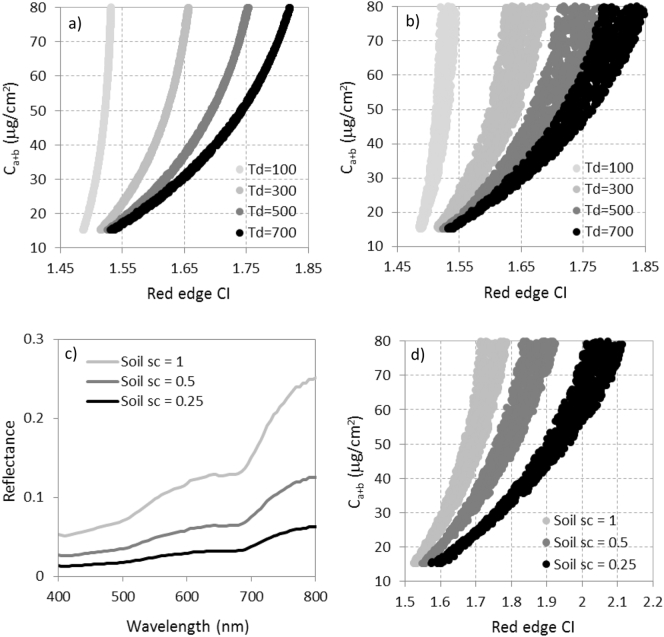
Simulations conducted to display the effects of the tree density (Td) variation for fixed (a) and variable crown diameter (Cd) and tree height (Ch) (b) on the red-edge chlorophyll index (CI) as a function of needle Ca+b. For a fixed tree density (Td = 500), the effects on CI as a function of variable soil spectra (c) generated three independent relationships (d) due to the prominent influence of the soil reflectance on open canopies.